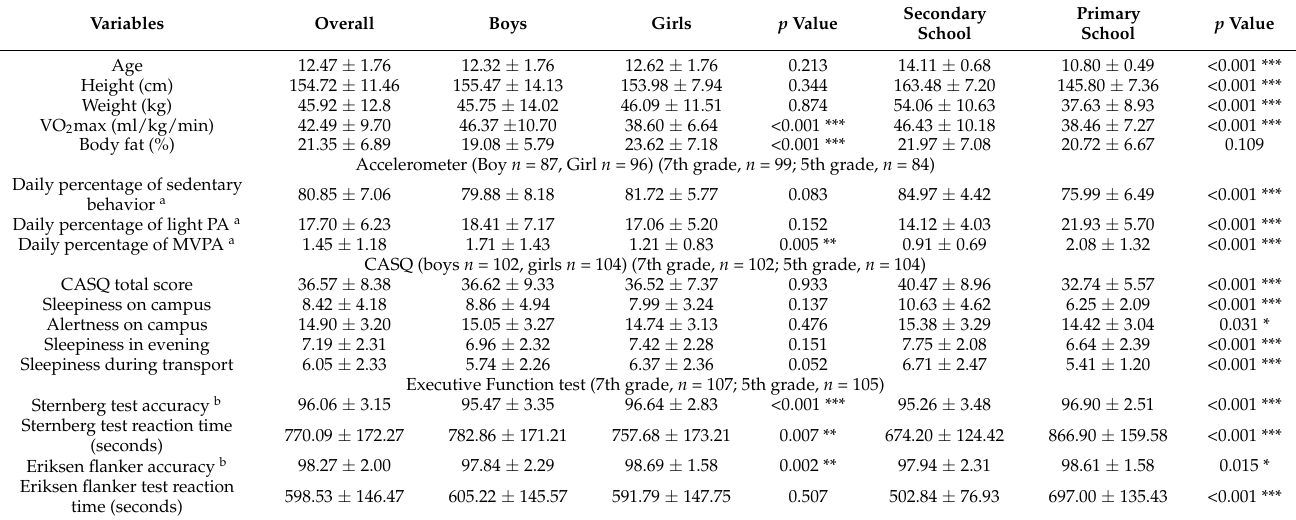
Table 1. Descriptive results of participants by sex and school ( n =